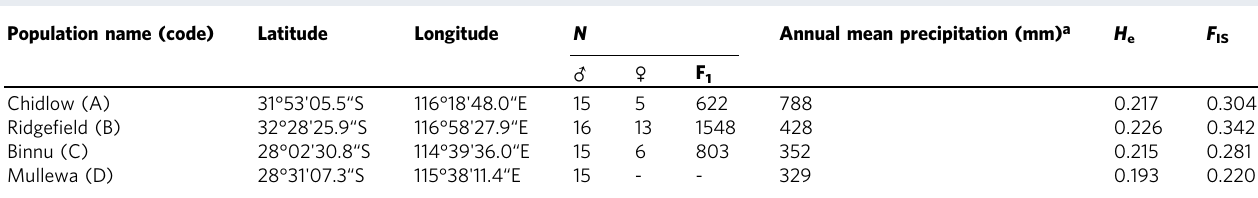
Table 1 Site characteristics, sample numbers and genetic diversity estimates 39 ( H e = mean expected heterozygosity, F IS = inbreeding coef fi cient) for each P. guentheri population.